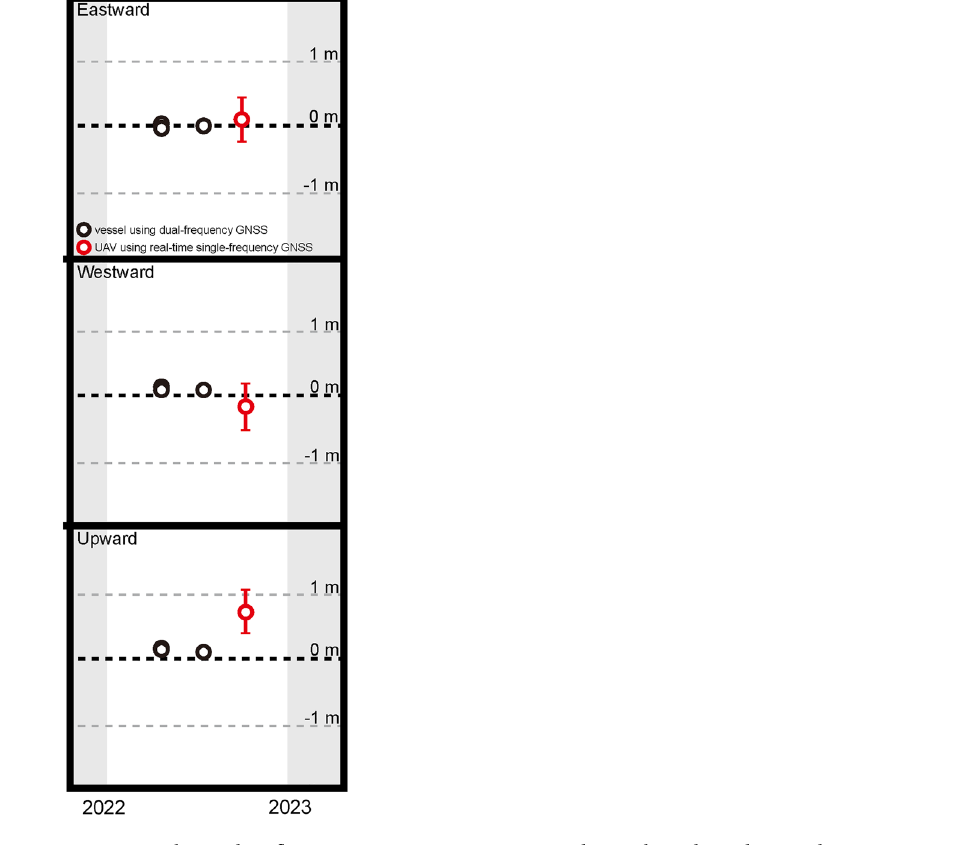
Figure 5. Obtained seafloor position time series. Eastwards, northwards, and upwards components are shown in order from the top. Black and red circles indicate results obtained by vessel-based GNSS-A using dual-frequency GNSS and UAV-based GNSS-A using single-frequency GNSS, respectively. Position error bars indicate a width of ± 1 σ obtained in